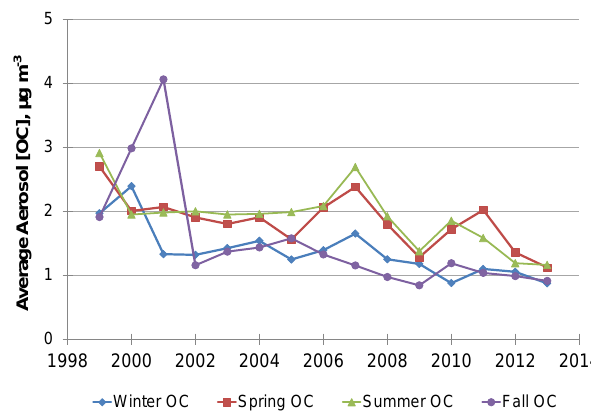
Figure 10. Trends in seasonal IMPROVE PM 2 . 5 OC mass at Look Rock.